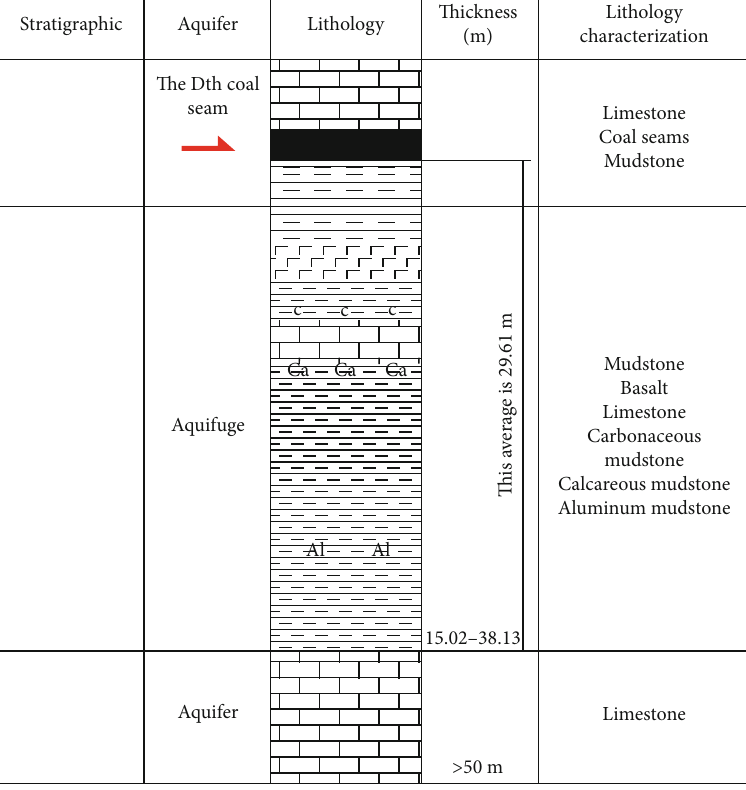
Figure 2: Structural relationship between coal seam and